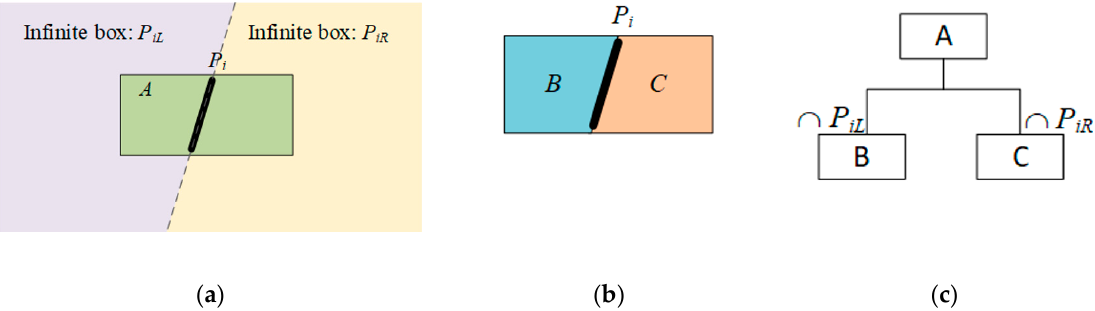
Figure 3. Illustration of a partition in the partitioning CSG-BRep tree. ( a ) A parent cell A and a planar primitive P i , with the two infinite boxes P iL and P iR generated from; ( b ) two child cells split from A ; ( c ) The partitioning process in the CSG-BRep tree, where ∩ denotes the intersection Boolean operator.